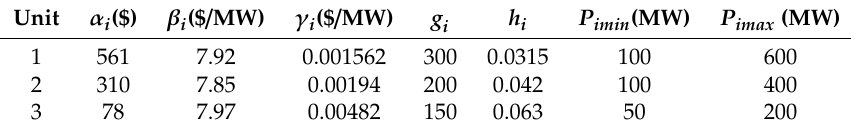
Table 4. Generator unit capacity and coe ffi cients on the second case study.